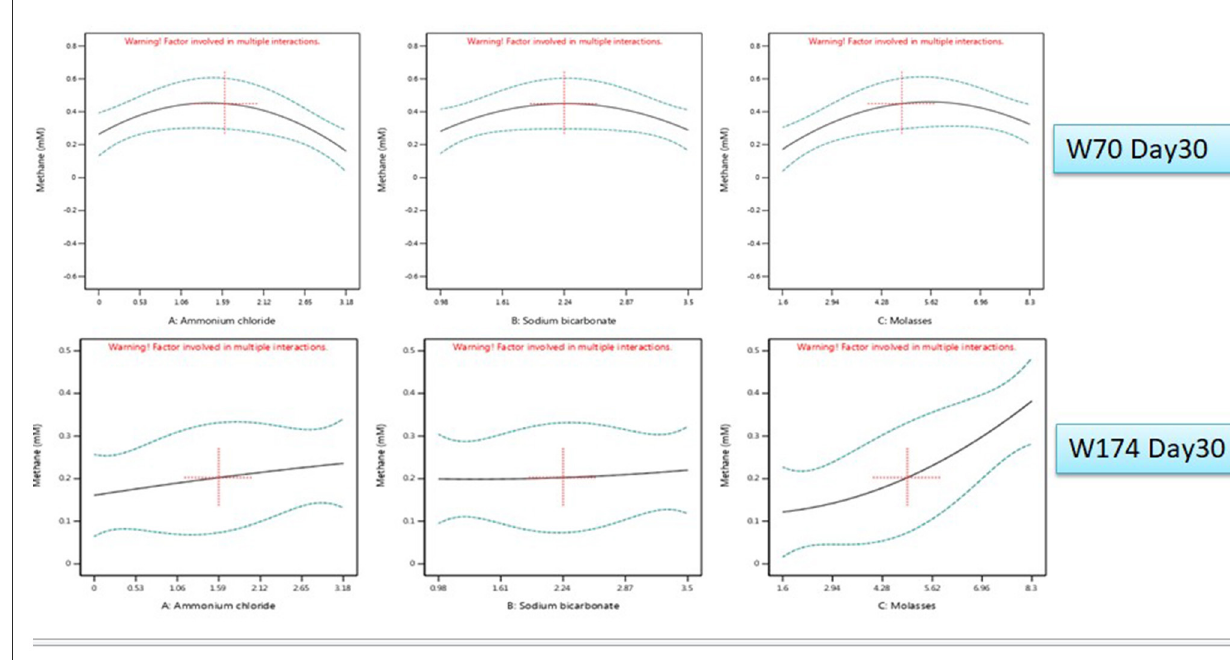
FIGURE6 All factor interaction for methane and VFA production (day 30) using Design Expert software.